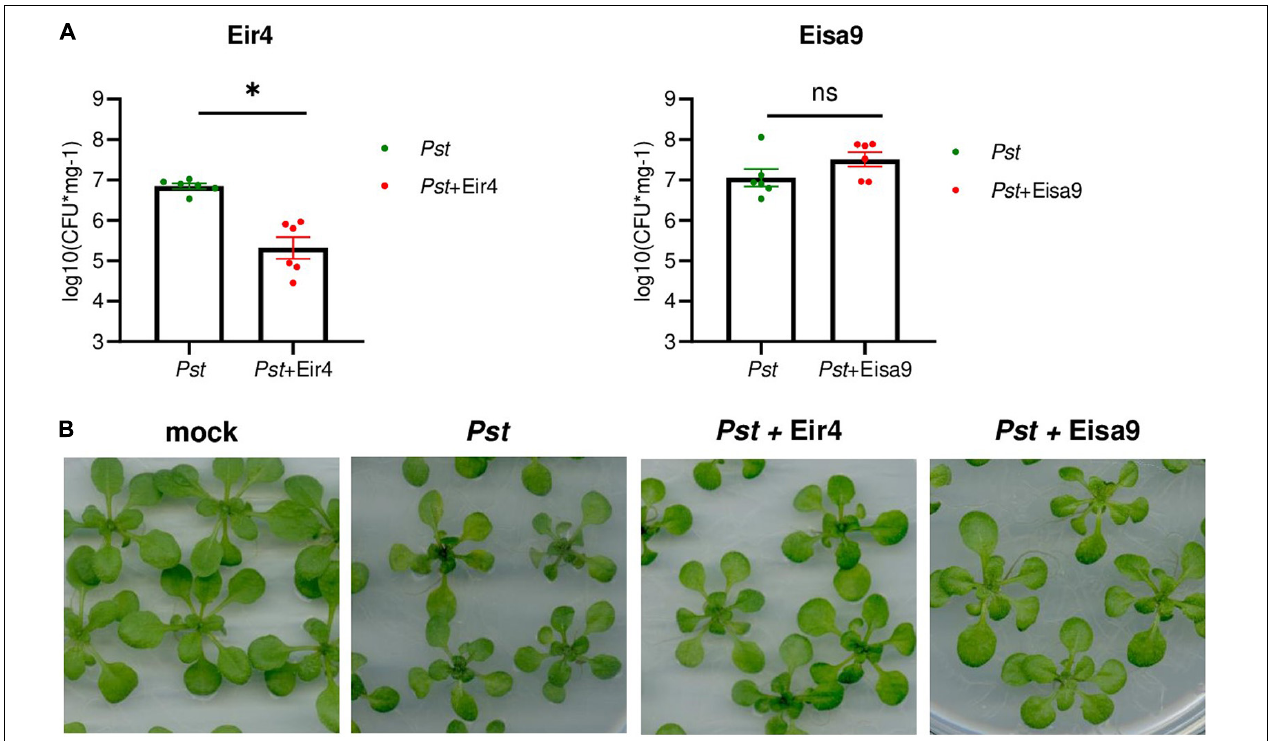
FIGURE 4 | Activity of Eir4 and Eisa9 against Pst in planta . (A) Efficiency of Eir4 (left panel) and Eisa9 (right panel) in a flood inoculation setup. Two-week-old seedlings of Arabidopsis thaliana Col-0 were flood-inoculated with a mixture of a phage with Pst . At 2 dpi, leaf tissues were harvested for quantification of bacteria propagated within tissues. Bars represent the mean ± SEM, and circles represent individual values. An asterisk indicates statistically different variants, p < 0.05, Student’s t -test, n = 6. (B) Representative images of A. thaliana plants treated with Pst or a mixture of Pst + Eir4 and Pst + Eisa9, flood inoculation setup, 2 dpi (bar 10 mm). Mock: 10 mM MgCl 2